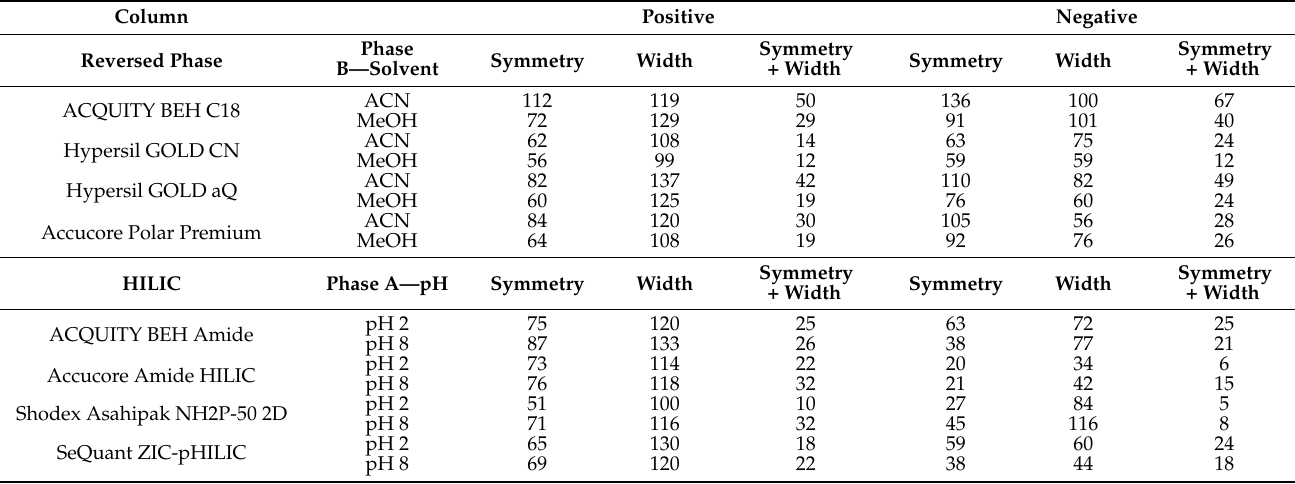
SeQuant ZIC-pHILIC pH